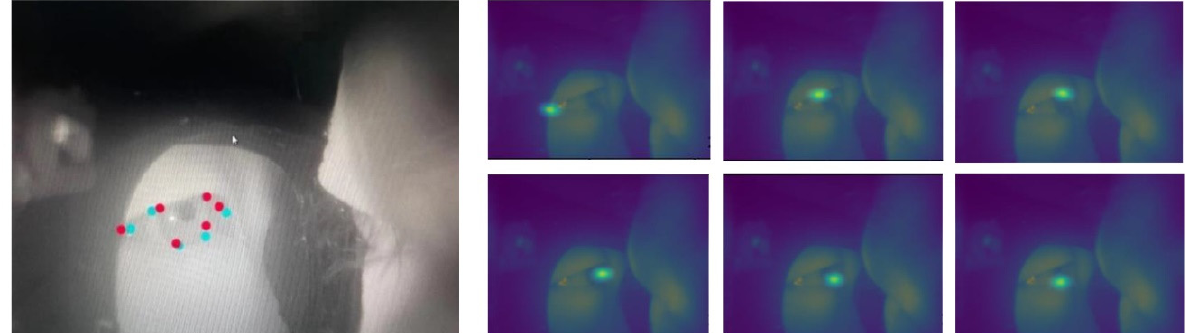
Figure 5. An illustration of the extracted eyelid keypoints ( left panel ) and the corresponding Gaussian probability maps estimated by the Feature Extraction Module ( right panel ).